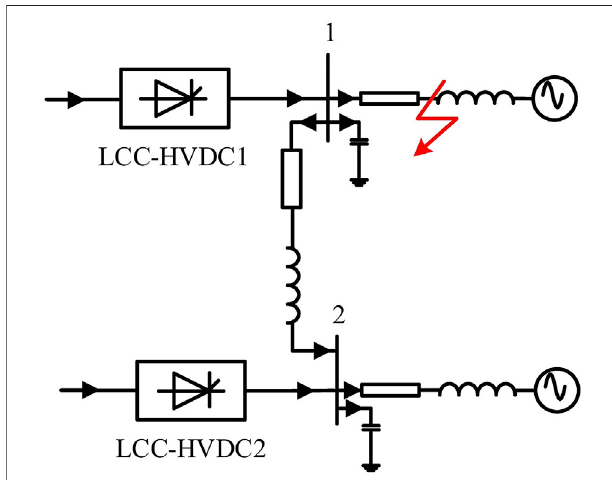
FIGURE 1 | Two-infeed HVDC equivalent system